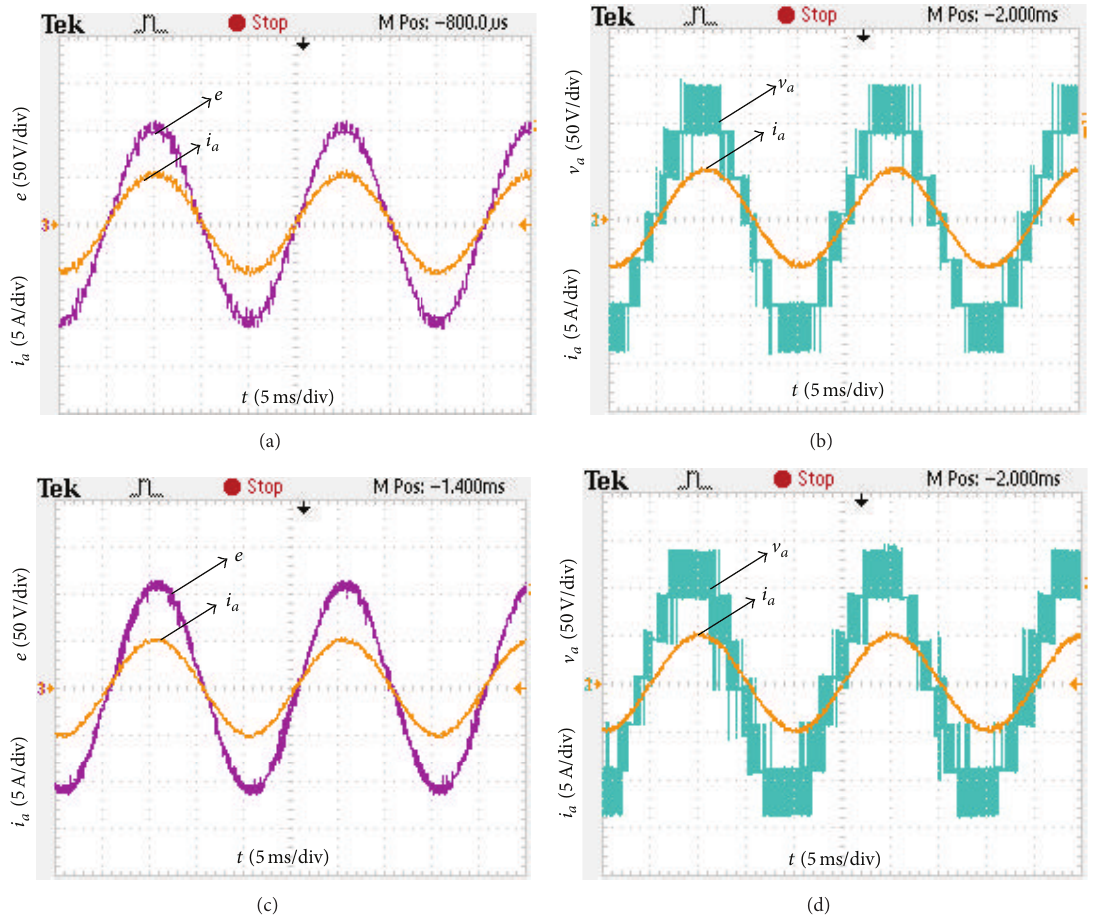
Figure 8: Experimental results in steady state: (a) Grid-connected current and grid voltage with conventional FS-MPC. (b) Output voltage and grid-connected current with conventional FS-MPC. (c) Grid-connected current and grid voltage with simplified FS-MPC. (d) Output voltage and grid-connected current with simplified FS-MPC.